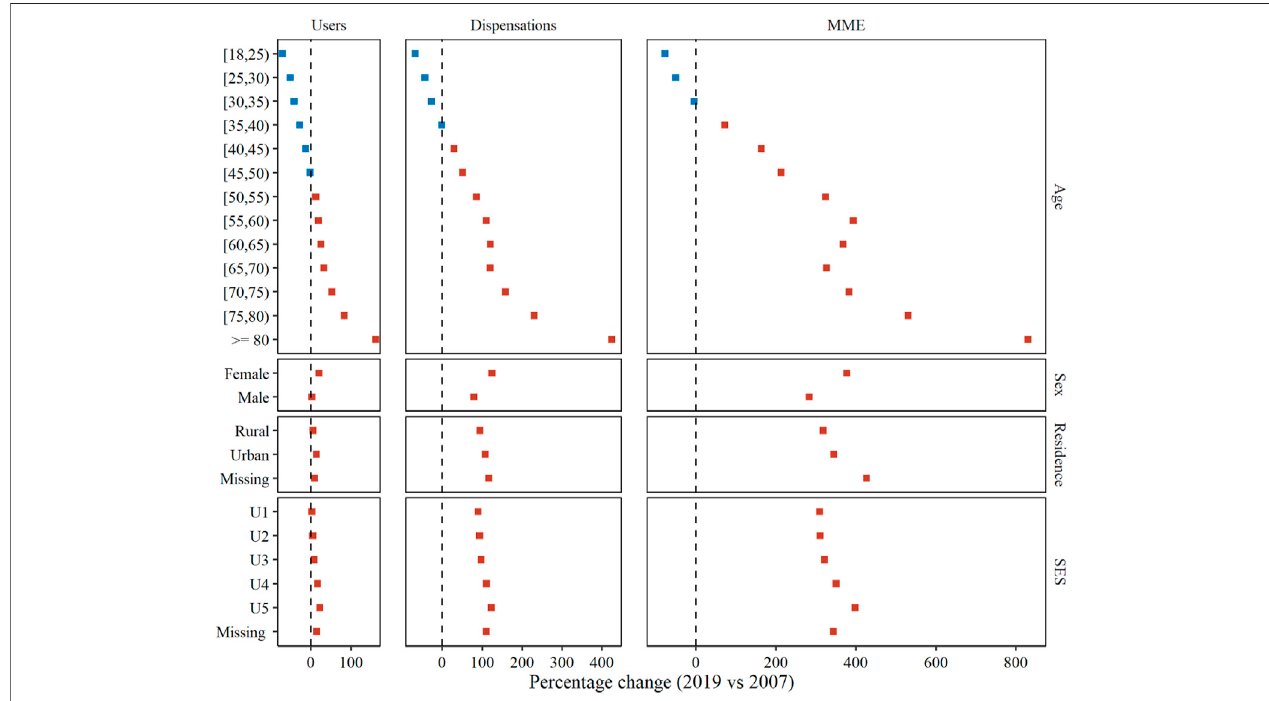
FIGURE 2 | Percentage changes of opioids use between 2007 and 2019 across